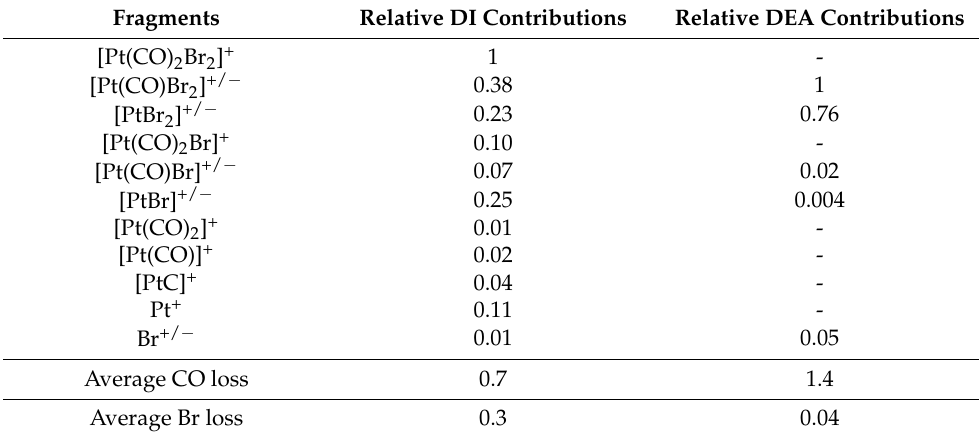
Table 3. Relative yields of the fragments formed by DI and DEA to Pt(CO) 2 Br 2 , average weighted CO loss per DEA and DI incident and average weighted Br loss per DI incident. Fragments Relative DI Contributions Relative DEA